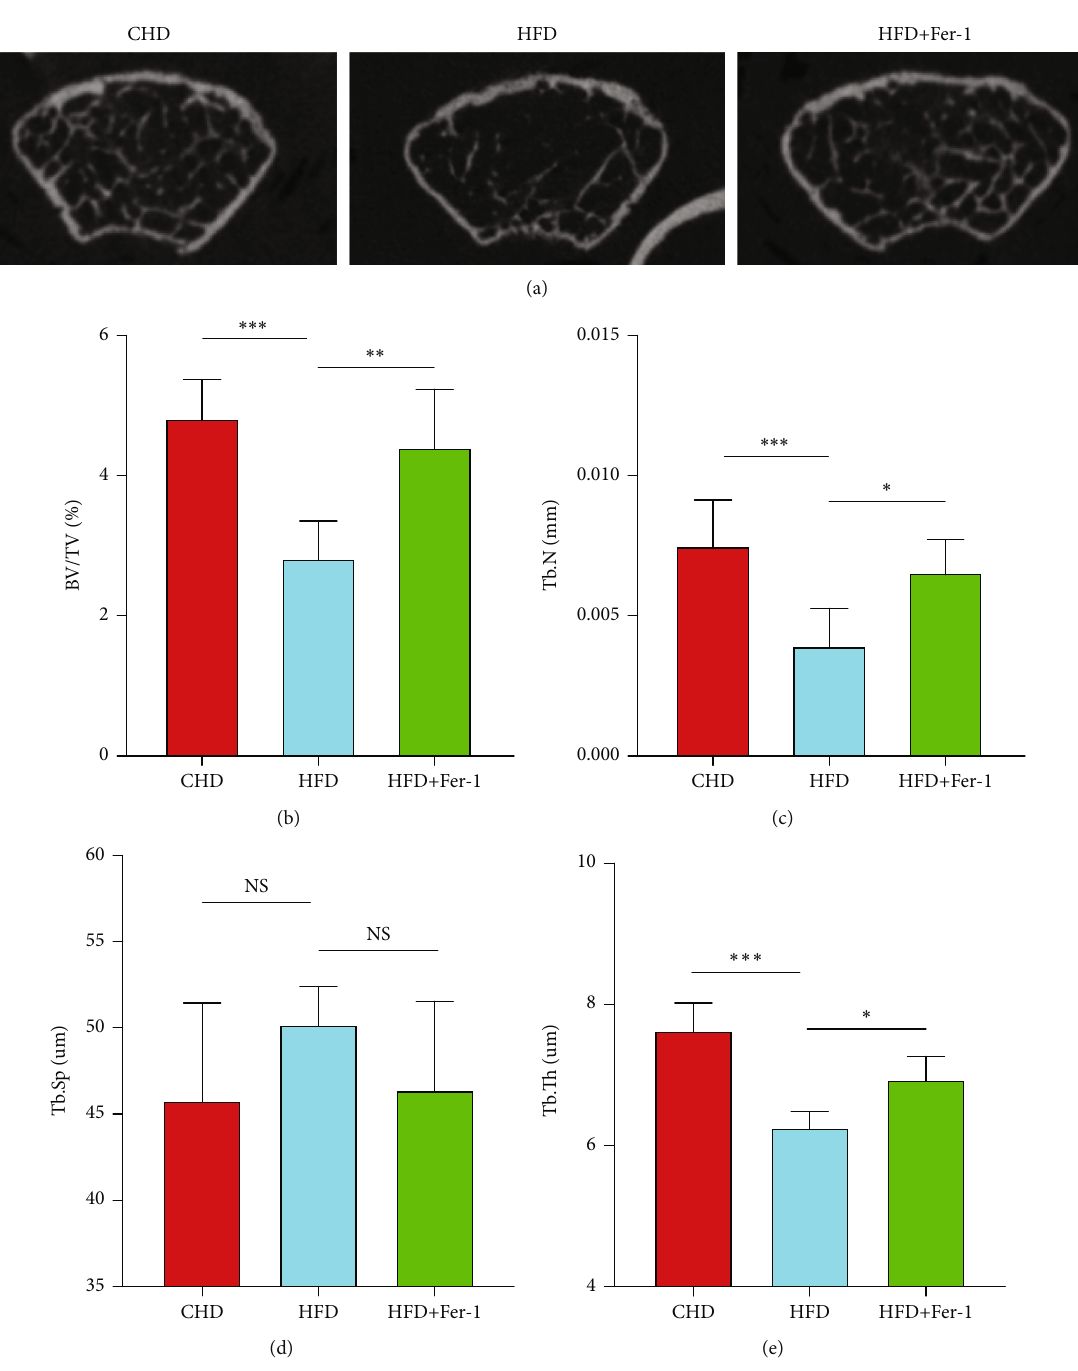
Figure 1: In this experiment, it was found that feeding mice a high-fat diet reduced bone mass production and that intraperitoneal administration of the ferroptosis inhibitor Ferrostatin-1 to mice fed a high-fat diet signi fi cantly reduced the bone mass loss in mice fed a high-fat diet. Representative micro-CT images of the distal femur of mice fed a normal diet, a high-fat diet, and a high-fat diet plus a ferroptosis inhibitor for 12 weeks (a). The femoral microstructure of mice was then quanti fi ed in terms of trabecular volume fraction (BV/TV) (b), trabecular number (Tb.N) (c), trabecular thickness (Tb.Sp) (d), and trabecular separation (Tb.Th) (e). n = 5/group , ∗ P